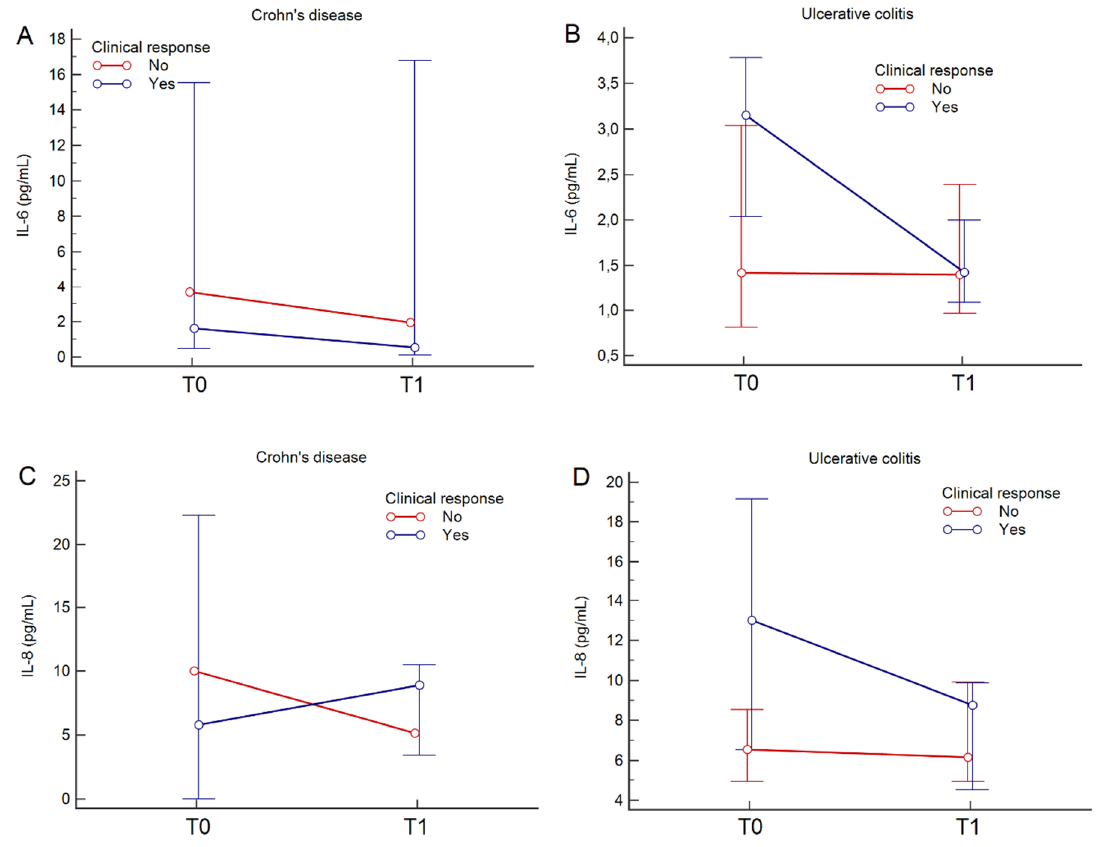
Figure 1. IL-6 and IL-8 variation from T0 to T1 in patients with CD ( A , C ) and UC ( B , D ) according to clinical response to treatment.